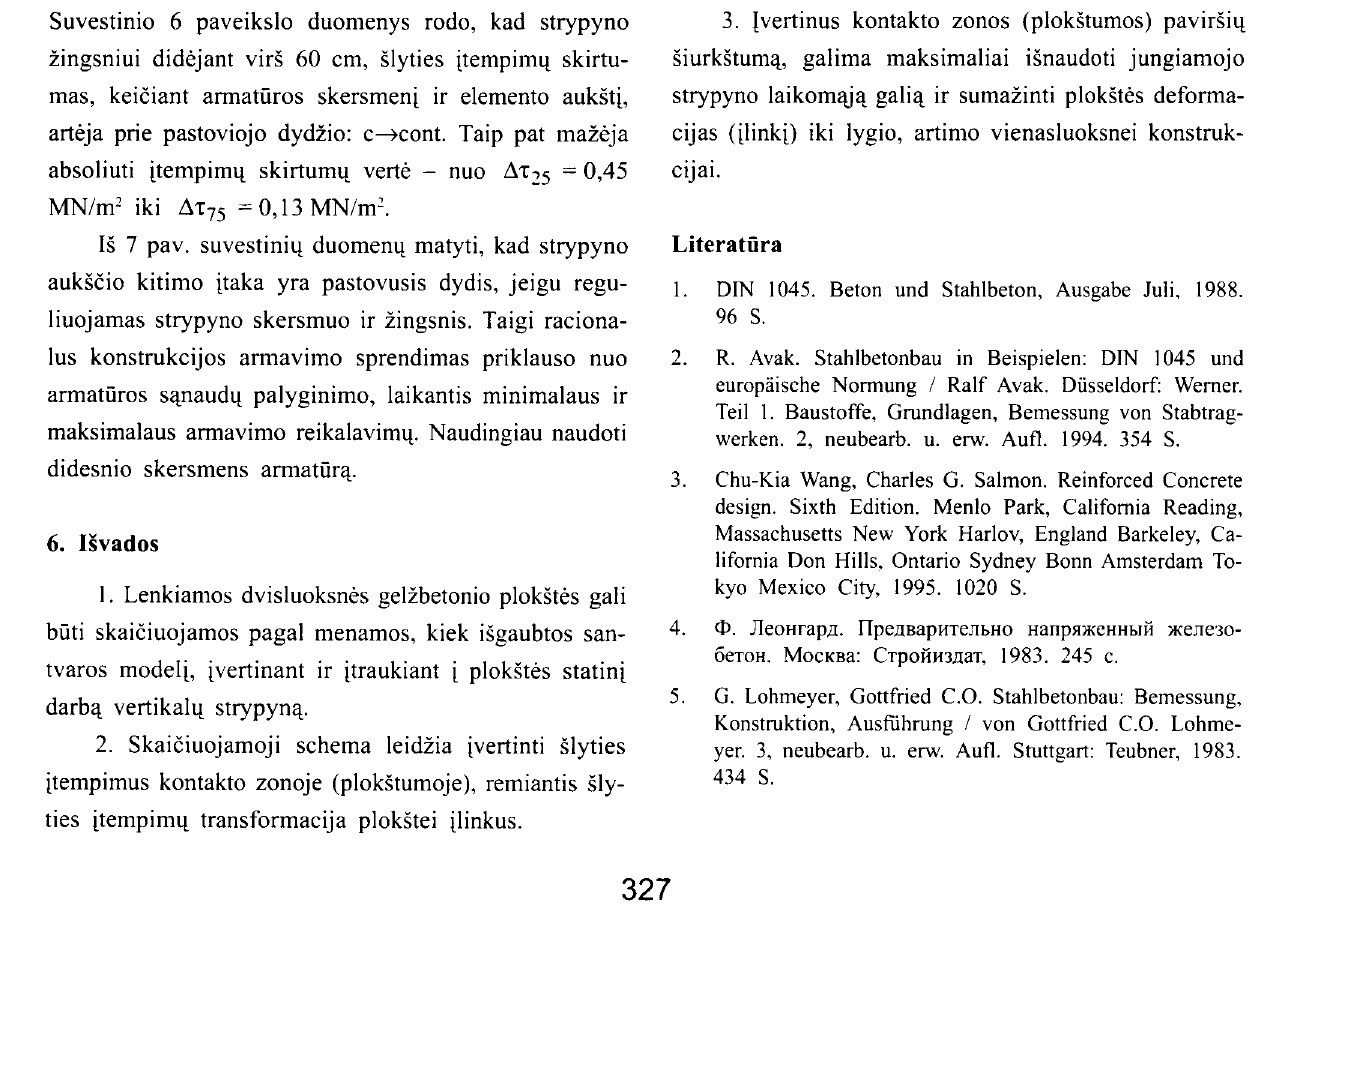
Suvestinio 6 paveikslo duomenys rodo, kad strypyno zingsniui didejant virs 60 em, slyties itempimq skirtu mas, keiciant armatiiros skersmeni ir elemento auksti, arteja prie pastoviojo dydzio: c~cont. Taip pat